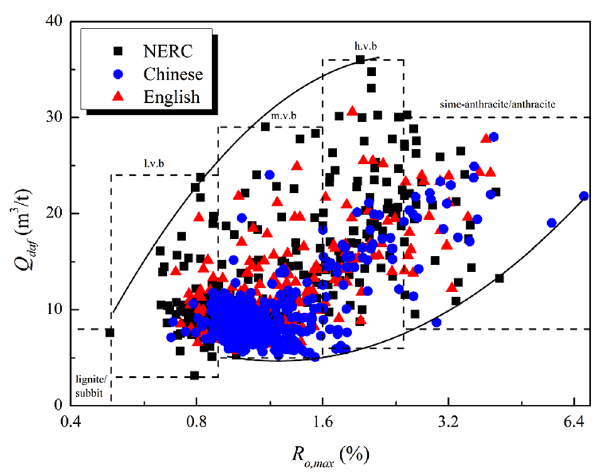
Fig. 4 Value of adsorption constant Q versus vitrinite reflectance R o ; max . (Data size: NERC-290, Chinese (Yu et al. 2008a; Ma et